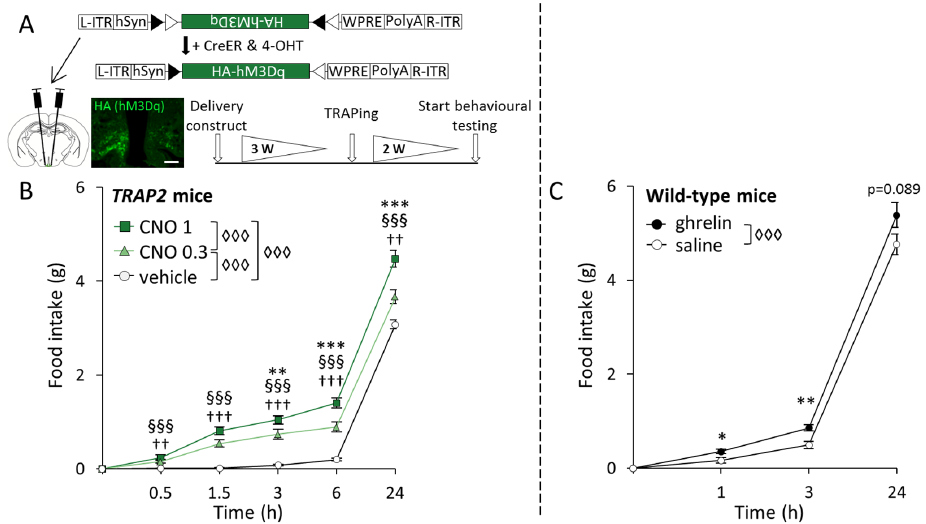
Figure 1. Food intake increases upon both the chemogenetic activation of ghrelin-responsive cells in the arcuate nucleus (Arc) and ghrelin injection. ( A ) The upper schematic shows the construct used and its recombination under the control of inducible Cre recombinase (CreER) and 4-hydroxy tamoxifen (4-OHT). Below is the schematic of the experimental timeline for the chemogenetic excitation of ghrelin-activated cells in the Arc, with time intervals in weeks (W). The fluorescence image is a representation of hM3Dq expression in the Arc of ghrelin-TRAPed mice, detected through anti-human influenza hemagglutinin (HA) immunohistochemistry. Scale bar: 100 µm; ( B ) Cumulative chow intake at different time points in mice that were ghrelin TRAPed (n = 13) and injected with 1 mg/kg CNO, 0.3 mg/kg CNO, or a vehicle in a cross-over fashion. Symbols represent: ◊◊◊ p < 0.001 (general effect of treatment); §§§ p < 0.001 (1 mg/kg CNO vs. vehicle); †† p < 0.01, ††† p < 0.001 (0.3 mg/kg CNO vs. vehicle); ** p < 0.01, *** p < 0.001 (1 mg/kg CNO vs. 0.3 mg/kg CNO); ( C ) Cumulative chow intake after saline or ghrelin administration to wild-type male mice (n = 9) in a cross-over fashion. Symbols represent: ◊◊◊ p < 0.001 (general effect of treatment); * p < 0.05 or ** p < 0.01 (ghrelin vs. saline). Error bars represent ± SEM in both figures.